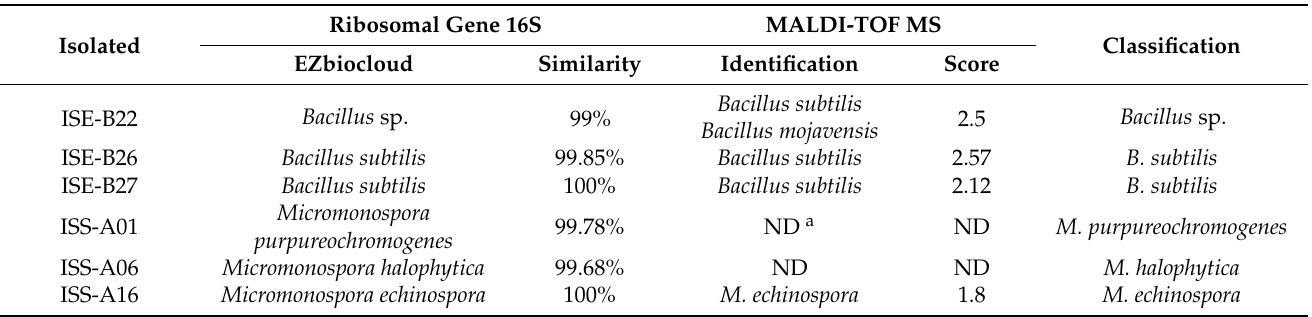
Table 3. Molecular identification based on the 16S ribosomal gene and mass spectrometry of endo- phytic and rhizosphere bacteria with antitumor